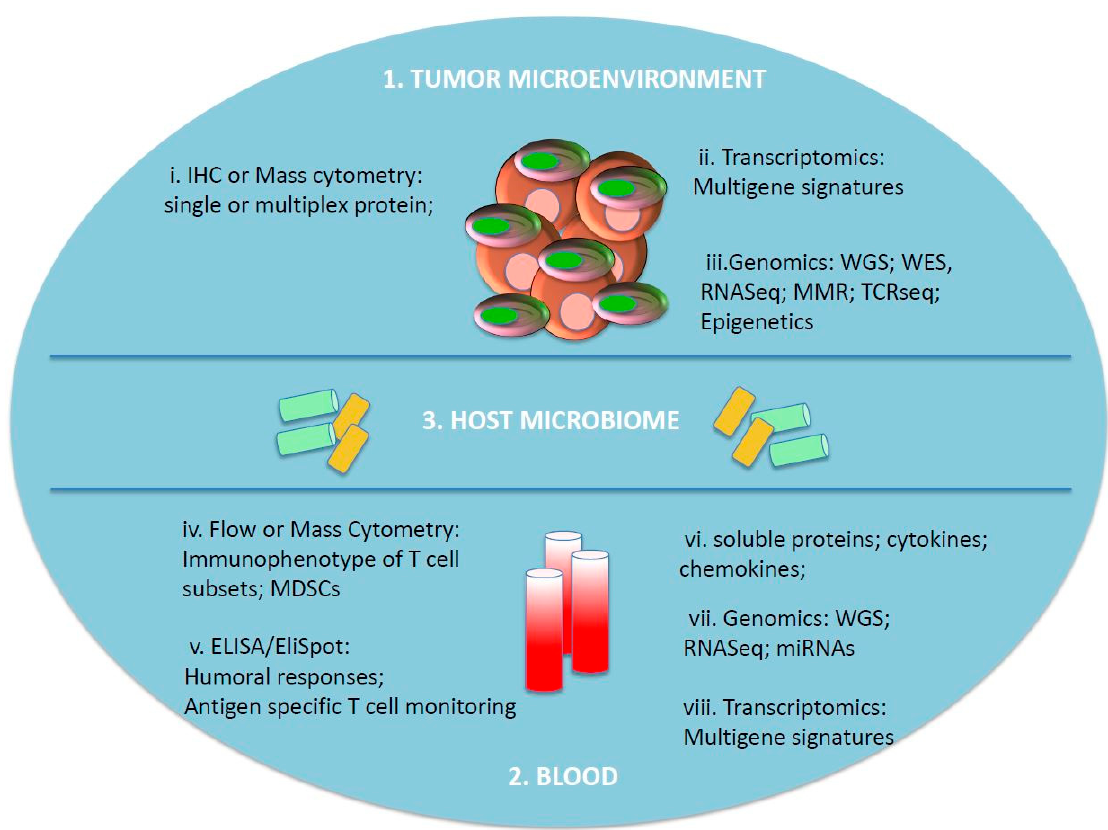
Figure 1. Immune profiling of cancer patients. 1. Tumor and immune cells in tissues specimens can be evaluated through IHC or mass cytometry for: i. defined marker expressions, assessment of type, quantity, and localization of immune infiltration, spatial relationship between tumor and immune cells. ii. Molecular analysis of gene signatures. iii. Genomic and epigenetic analyses. Ideally, a longitudinal analysis of tumor tissues should be performed to monitor changes along with treatment regimens. 2. Peripheral blood represents a minimally invasive procedures to monitor dynamic changes of immune responses through: iv. Immunophenotypic characterization of subpopulations of lymphocytes and monocyte/myeloid cells. v. Monitoring antigen-specific T cell responses or humoral responses. vi. Assessment of soluble biomarkers. vii. Genomic profiling of blood cells. viii. Transcriptomic analyses. 3. Host microbiome can shape the immune responses and affect patients’ clinical outcome after immunotherapy. The assessment of microbiome genomics is assuming a relevant role in immune monitoring of cancer patients. IHC: immunohistochemistry; WGS: whole-genome sequencing; WES: whole-exome sequencing; RNAseq: sequencing of RNA; TCR seq: sequencing of T cell receptor; miRNAs: microRNAs; MDSCs: myeloid-derived suppressor cells; ELISA: enzyme-linked immunosorbent assay; EliSpot: enzyme-linked immunospot assay; miRNAs: micro